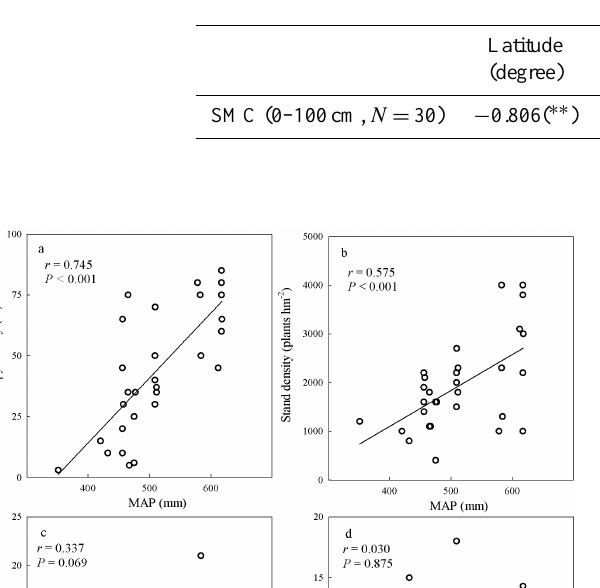
Table 1. Correlation analyses between depth-averaged SMC and spatial parameters ( N = 30; ∗∗ P < 0 . 01).